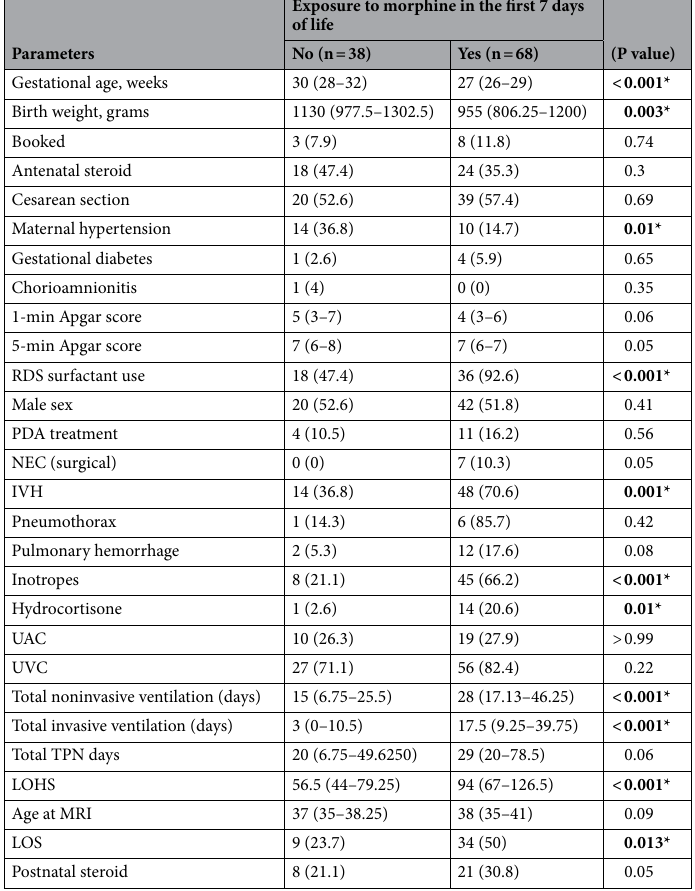
space, total cortical GM score, and deep GM signal abnormalities. Multivariable regression analysis revealed that early morphine exposure remained significantly associated with increased total WM score after adjusting for variables that were found to be significant in the univariate analysis (adjusted relative risk [aRR] 1.32, 95% confidence interval [CI] 1.01–1.72). Additionally, early morphine exposure was associated with cerebellar vol- ume reduction (aRR 1.28, 95% CI 1.02–1.61) and increased total cerebellum score (aRR 1.36, 95% CI 1.03–1.81; Table 3). Besides, in the multivariable regression analysis we found that cumulative morphine doses were sig-